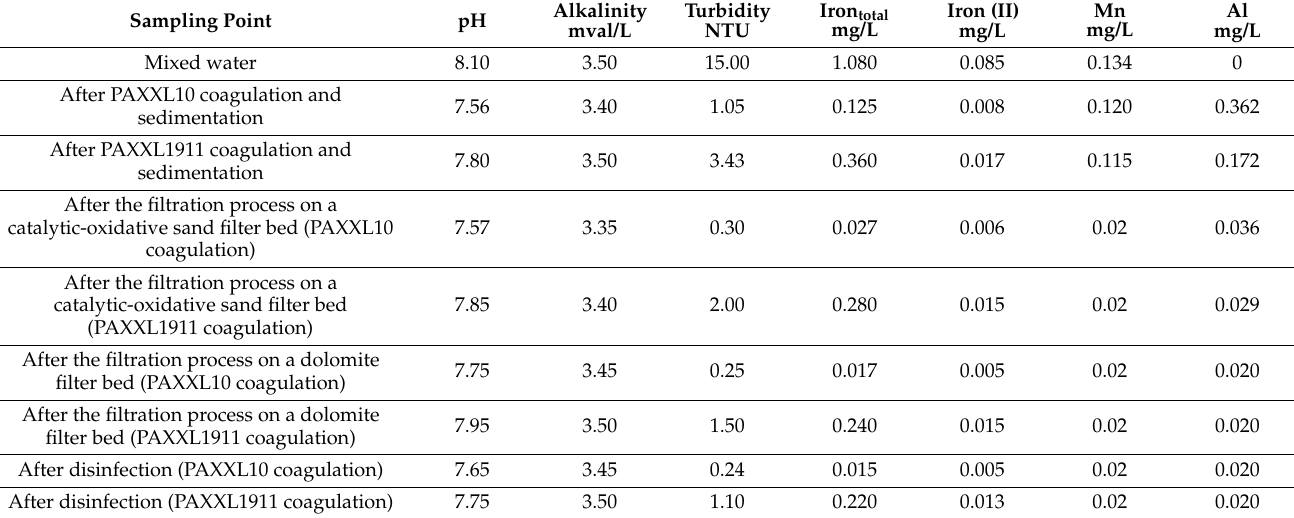
Table 2. Physical and chemical properties of water after individual stages of its